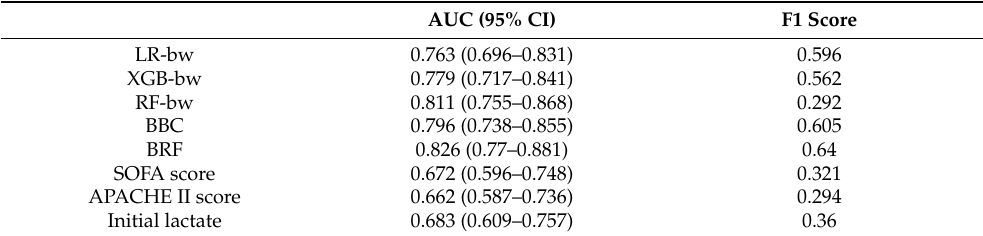
AUC, area under the curve; APACHE II, Acute Physiology and Chronic Health Evaluation; BBC, balanced bagging classifier; BRF, balanced random forest; CI, confidence interval; LR-bw, logistic regression with balanced weight; ML, machine learning; SOFA, Sequential Organ Failure Assessment; RF-bw, random forest with balanced weight; XGB-bw, XGB with balanced